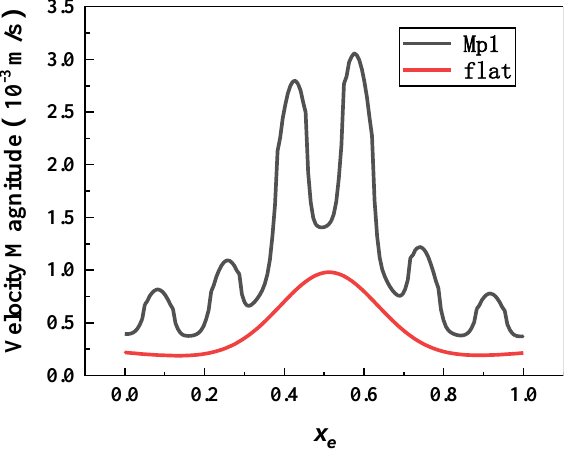
Figure 6. Velocity distribution on the microstructural surface with d c = 0.1 µ m. The x e is normalized coordinates.